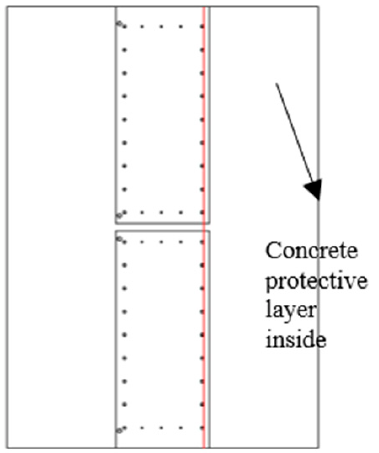
Figure 24. Position selection diagram of longitudinal section line.